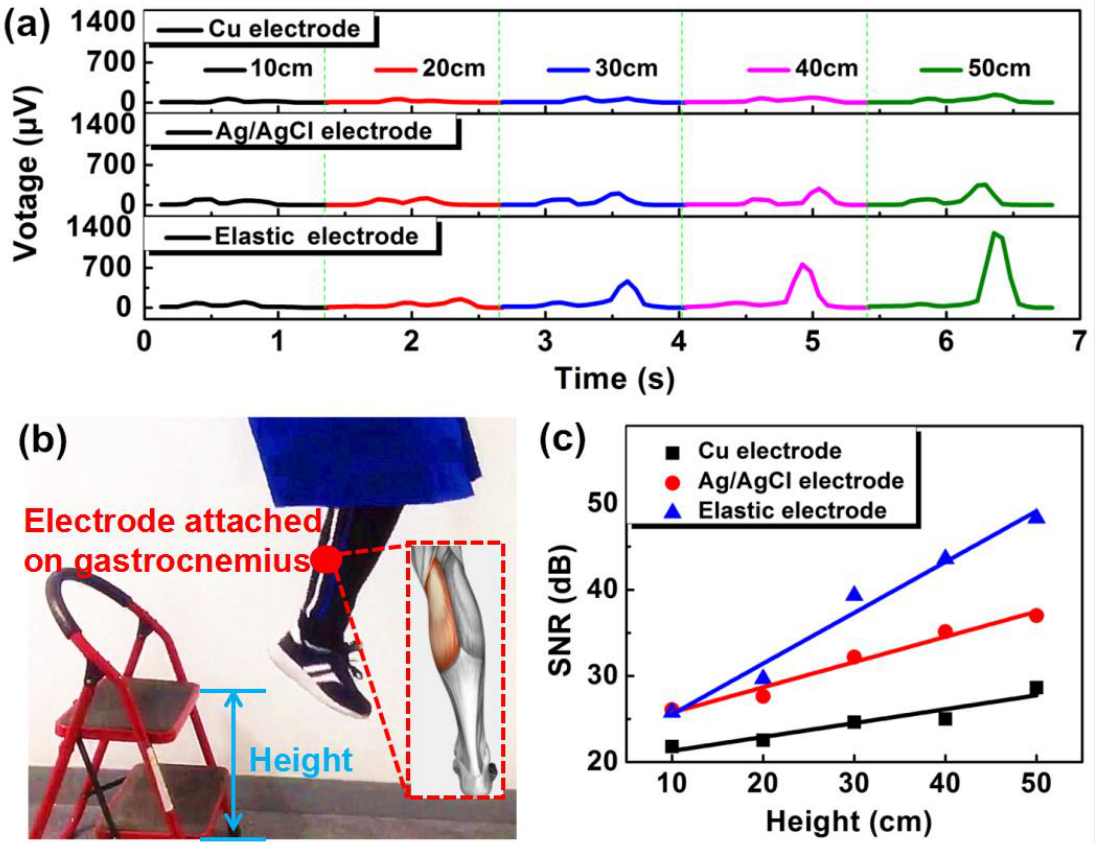
Figure 5. Application demo of our sEMG electrode. ( a ) Comparison of sEMG signals obtained after jumping from different heights (10, 20, 30, 40, and 50 cm). ( b ) sEMG electrode attached on gastrocnemius muscle of the right leg. Inset shows the gastrocnemius muscle of human leg. ( c ) SNR values comparison of various sEMG signals.